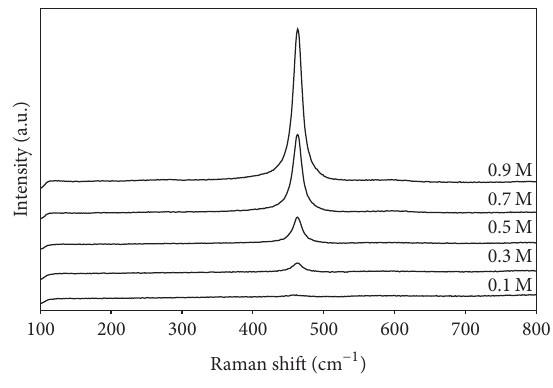
F 1: Laser Raman microspectra of CeO solutions of varying Ce concentrations.